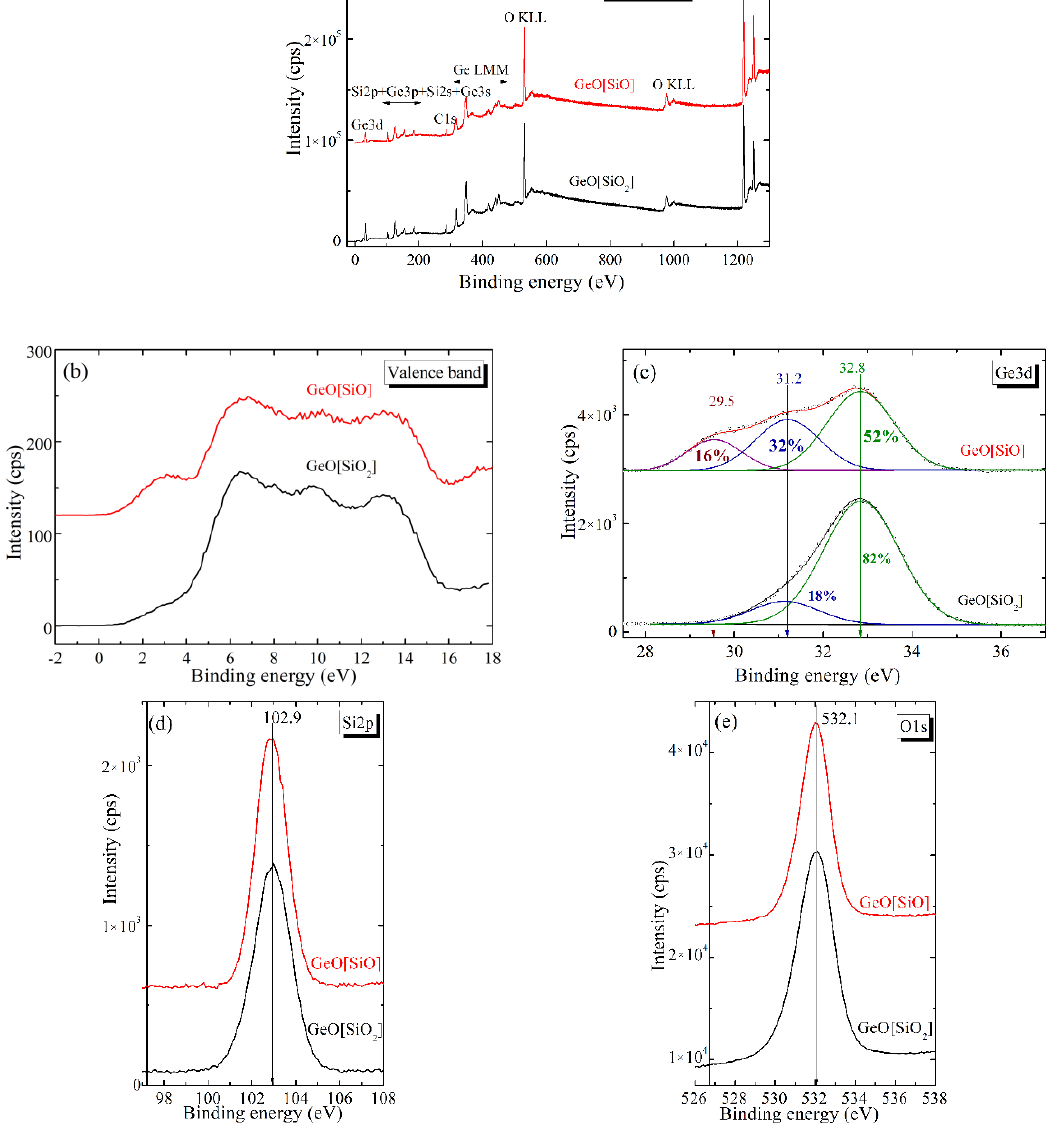
Figure 1. X-ray photoelectron spectra (XPS) data of the as-deposited thin GeO[SiO 2 ] and GeO[SiO] films. ( a ) Survey spectra; ( b ) valence band region; ( c ) Ge3d region; ( d ) Si2p region; and ( e ) O1s region. Table 1. The near-surface composition of the studied samples in atomic percents. Sample Ge, at.% Si, at.%